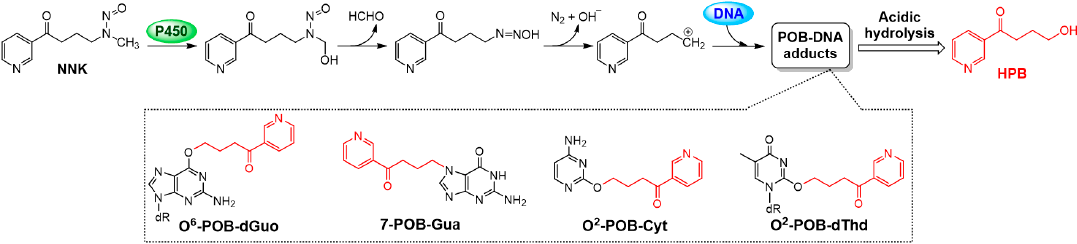
Figure 4. P450-catalyzed metabolic activation of NNK and formation of POB-DNA adducts, mainly including O 6 -POB-dGuo, 7-POB-Gua, O 2 -POB-Cyt, and O 2 -POB-dThd, which release HPB under acidic hydrolysis.